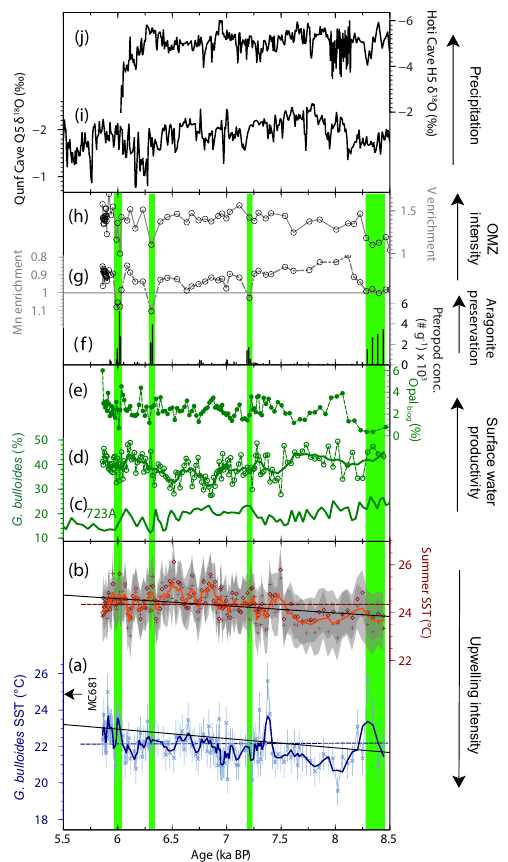
Figure 6. Time series of reconstructed SST from (a) the Mg / Ca ratio of G. bulloides (blue) indicating upwelling SST and (b) the consensus from the assemblage-based transfer function methods, IK and WA-PLS (red), indicating average summer SST (July– September). Thin lines and symbols represent real data; thick dashed lines represent the 3pt running averages. Relative abun- dance of G. bulloides from IODP site 723A from Gupta et al. (2005) (c) and SL163 (d) , together with biogenic opal content (e) , indicate phases of increased surface water productivity. Aragonite preservation is indicated by the concentration of pteropod frag- ments (f) and bottom-water oxygen conditions, and state of the oxygen minimum zone (OMZ) is shown with relative enrichment or depletion of manganese (g) and vanadium (h) . Note the in- verse relationship of both elements, as explained in the text. Sta- ble oxygen isotopes of (i) Qunf Cave (Fleitmann et al., 2007) and (j) Hoti Cave stalagmites (Neff et al., 2001) expressing precipita- tion in Oman. Vertical solid green bars indicate periods of low bio- genic opal content, concomitant with decreased OMZ intensity and increased aragonite preservation. Error bars for panel (a) were cal- culated by propagating the errors introduced by the Mg / Ca mea- surements and the Mg / Ca–temperature calibration (Gaussian error propagation; see Mohtadi et al. (2014)). Grey shading gives the un- certainty estimates for the transfer functions in panel (b) , based on the sample-specific root mean square error of prediction (RMSEP) using bootstrapping cross validation.